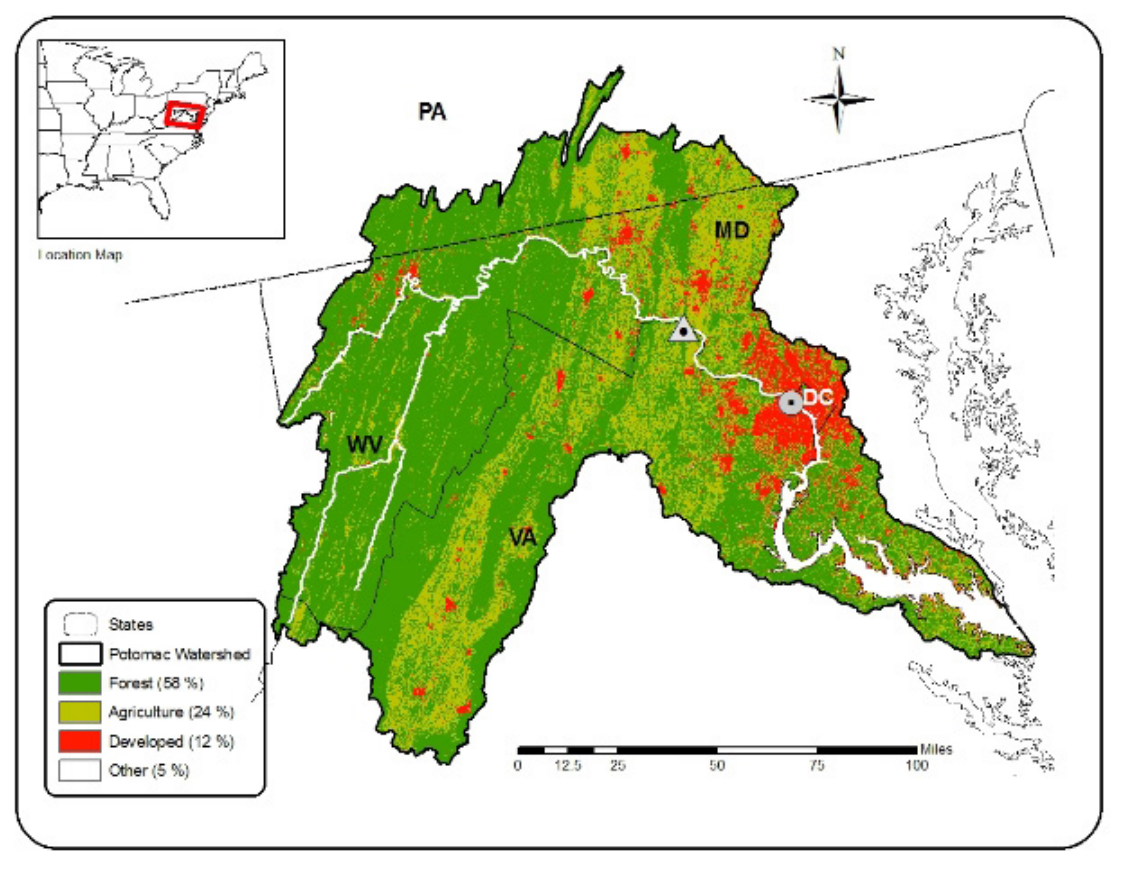
Fig. 1. Land-cover map of the Potomac River watershed. Classification is based on 2000 Mid-Atlantic Regional Earth Science Applications Center land-cover mapping of the Chesapeake Bay watershed. The percentage of watershed in each cover category is provided in the legend. The triangle indicates the location of the Point of Rocks monitoring station; the circle indicates the approximate location of the Washington, D.C., withdrawal site near Little Falls. PA, Pennsylvania; MD, Maryland; WV, West Virgina; DC, Washington, D.C.; VA,